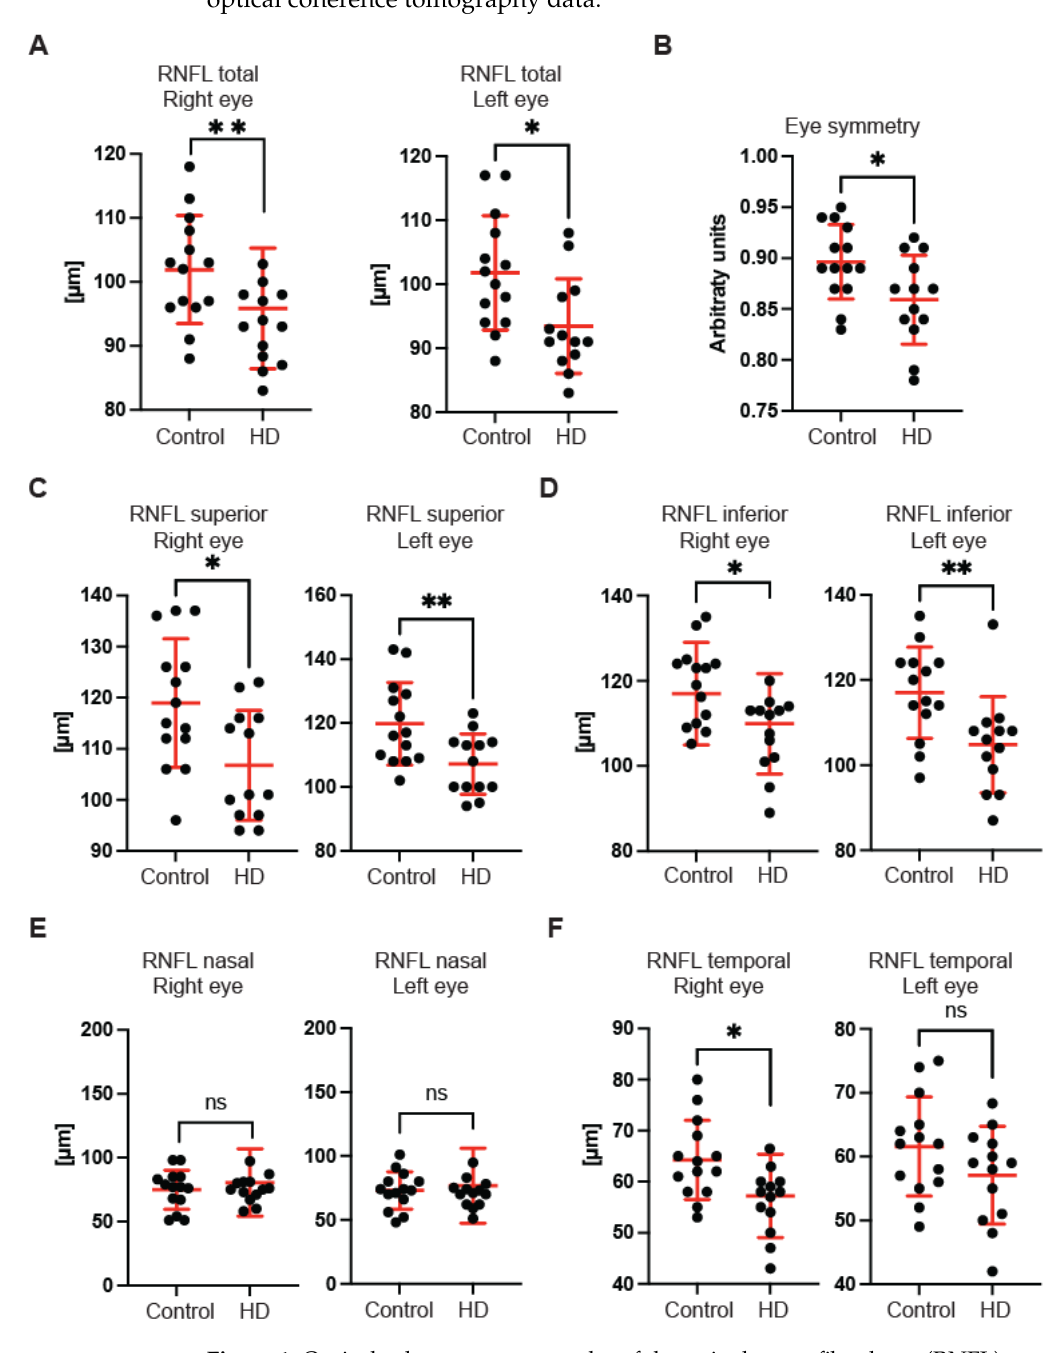
Figure 1. Optical coherence tomography of the retinal nerve fibre layer (RNFL) parameters in HD gene carriers and healthy controls. The following parameters have been assessed in pre-symptomatic HD carriers and age- and sex-matched healthy individuals: ( A ) total RNFL thinning, ( B ) the eye symmetry, ( C ) superior RNFL thinning, ( D ) inferior RNFL thinning, ( E ) nasal RNFL thinning and ( F ) temporal RNFL thinning. Error bars are ± SD ( n > 13). One-way ANOVA with Bonferroni post hoc test: * p < 0.05, ** p <